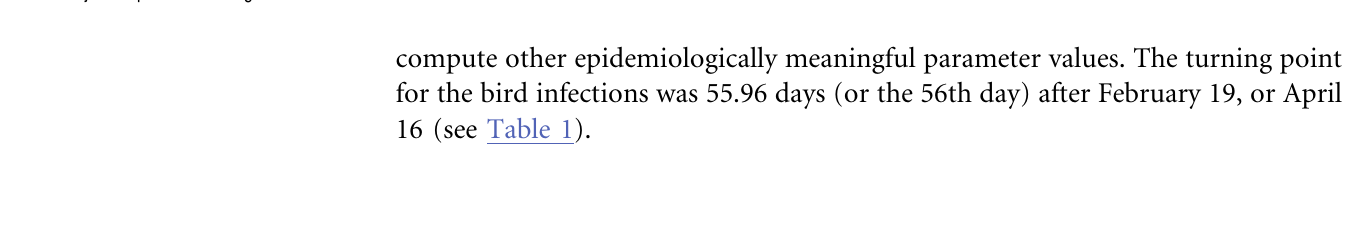
Figure 2. Model fit for cumulative human H7N9 case number in China, February 19-May 10, 2013 using the Richards model (2).